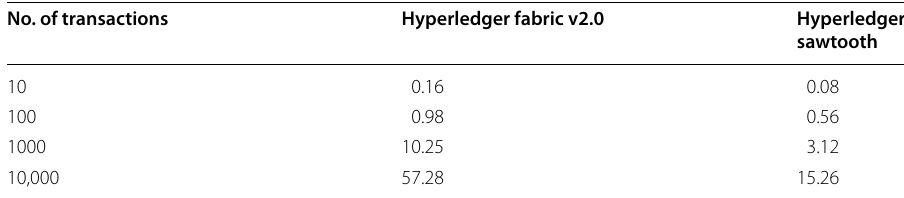
No. of transactions